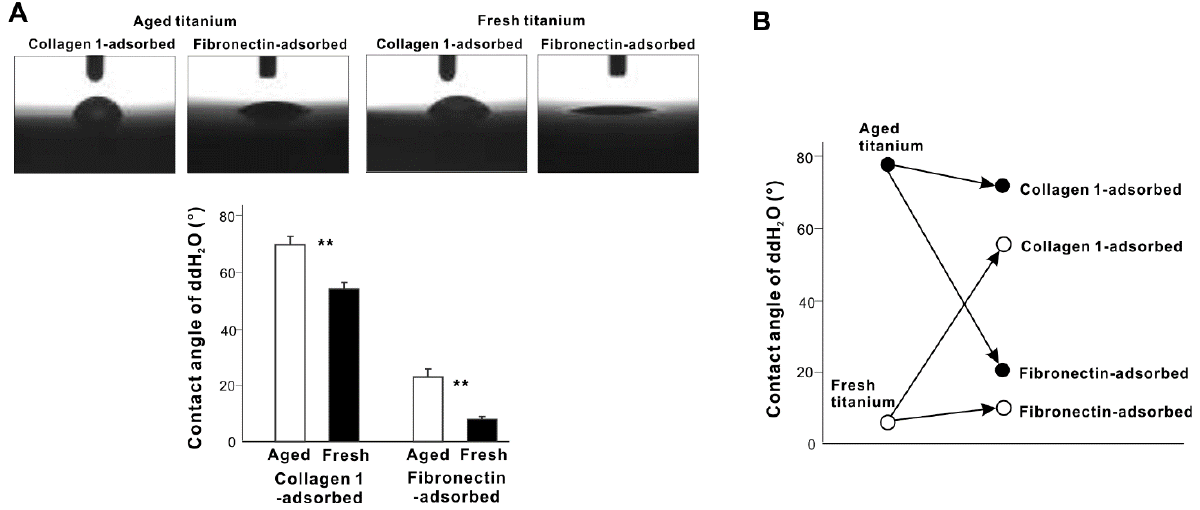
Figure 3. Hydrophobic/hydrophilic state of titanium disks with protein pre-adsorption. ( A ) Side- view photographs of a 1 µ L drop of ddH 2 O placed on a protein-pre-adsorbed titanium disk and a histogram showing contact angle measurements. ** p < 0.01, statistically significant difference between fresh and aged titanium surfaces. ( B ) Summary of hydrophobic/hydrophilic changes before and after protein adsorption based on Figures 1D and 3( A ) . Surfaces with a contact angle of ≥40° are defined as hydrophobic, and surfaces with a contact angle <40° are defined as hydrophilic.